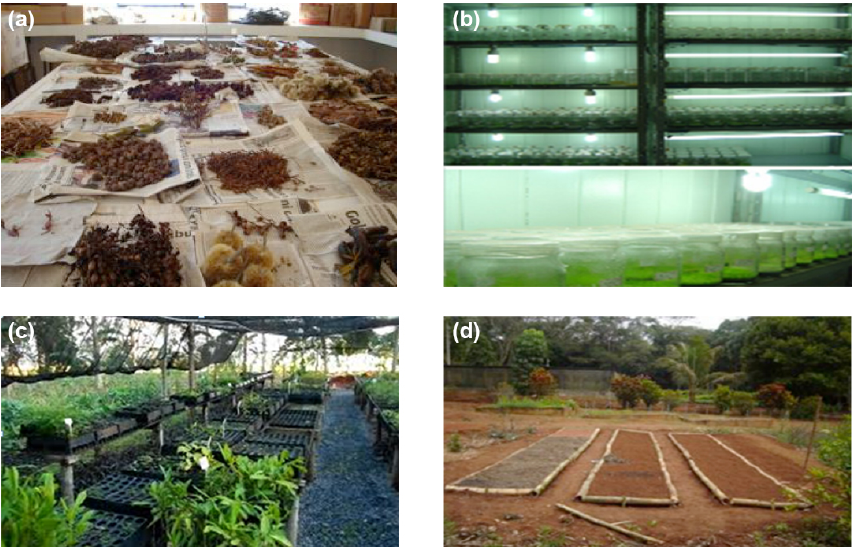
Figure 2. Seeds (a) , greenhouse saplings (b) , nursery of canga vegetation species (c) , and outdoor beds (d) . Photo credit: A. F.